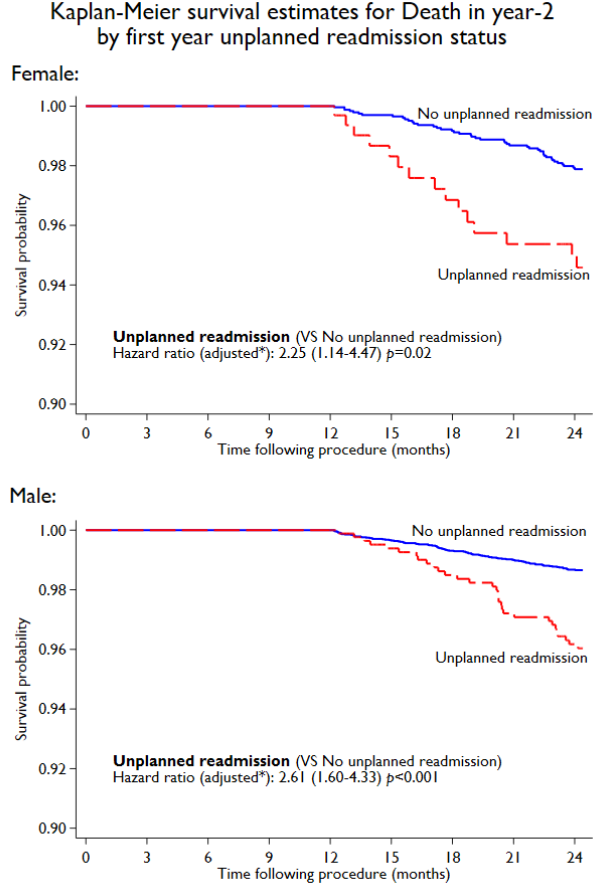
Figure 3. Association of unplanned cardiac readmissions in first year with death in year 2 among the study cohort. * Adjusted for age, diabetes, BMI, hypertension, hypercholesterolemia, previous history of MI, PVD, or CABG, smoking, renal dysfunction, pci presentation, and multivessel disease.